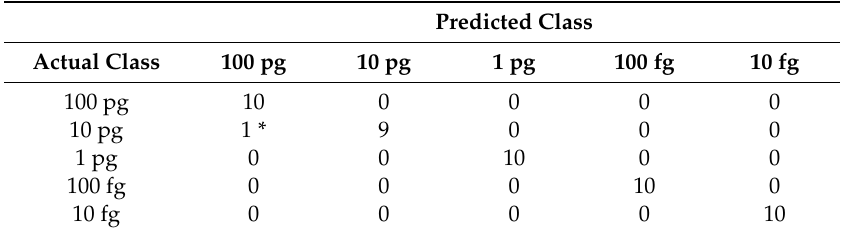
Table 5. Confusion matrix for the training sets obtained by the linear support vector machine (SVM) model. The asterisk sign (*) denotes the misclassified analyte quantity for the training LFA sets.